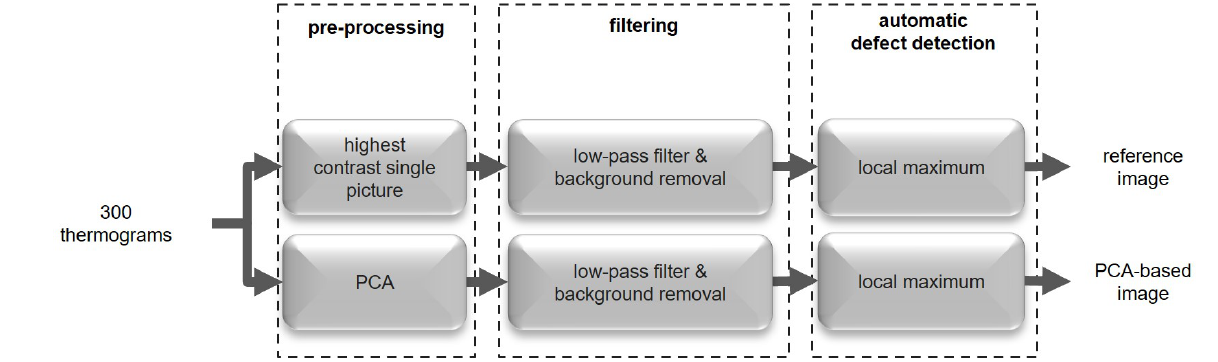
Figure 5. Signal flow diagram of the image processing